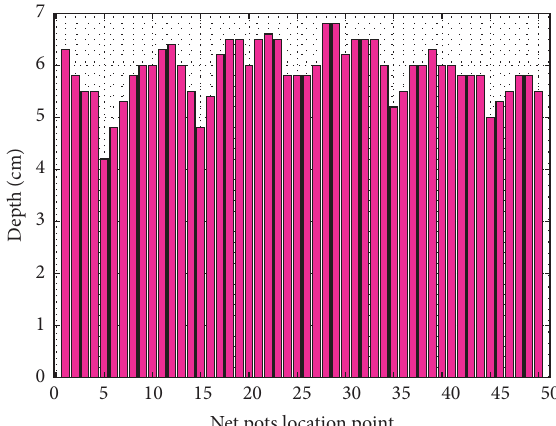
Figure 9: Water depth in the self-fertigation system.